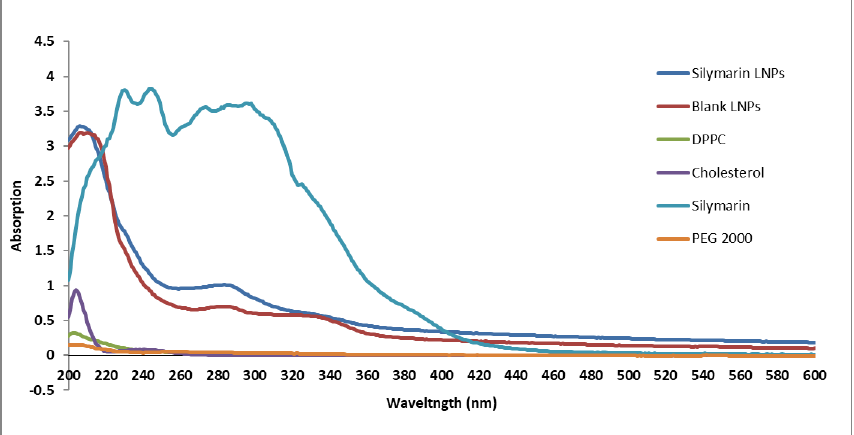
Figure 1. Comparative UV – VIS spectra of blank and silymarin LNPs and their components DPPC, cholesterol, silymarin, and PEG 2000, using a UV – Vis 2800 (BMS Biotechnology Medical Services, Madrid, Spain).